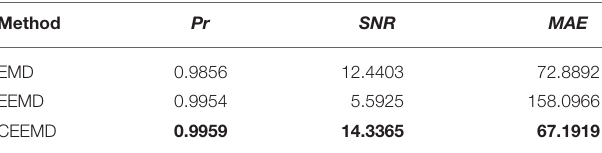
TABLE 2 | Evaluation indexes reconstructed by different decomposition methods.